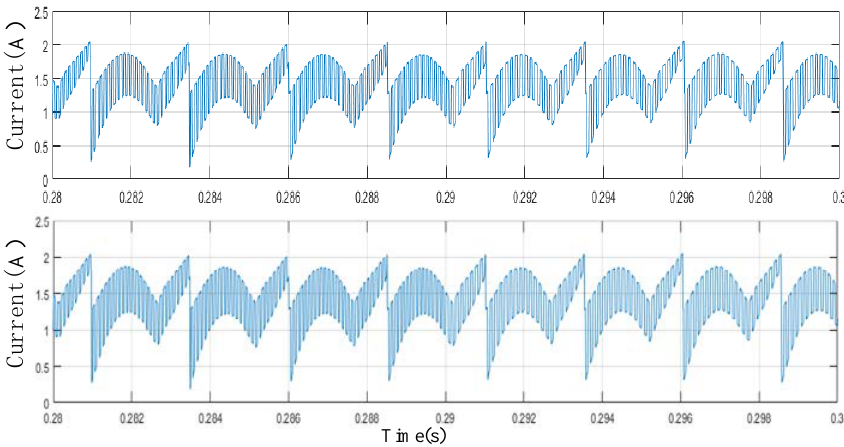
Figure 17. DC-bus current after signal modulation on upper and lower devices.